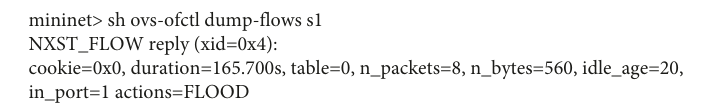
Figure 7: An example of the traffic flow information from a switch.